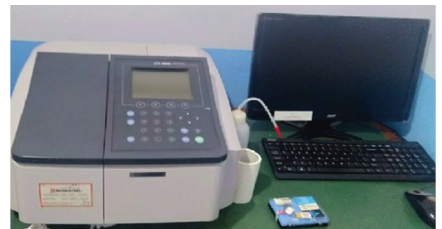
Figure 3: Photograph of UV-visible spectrophotometer.